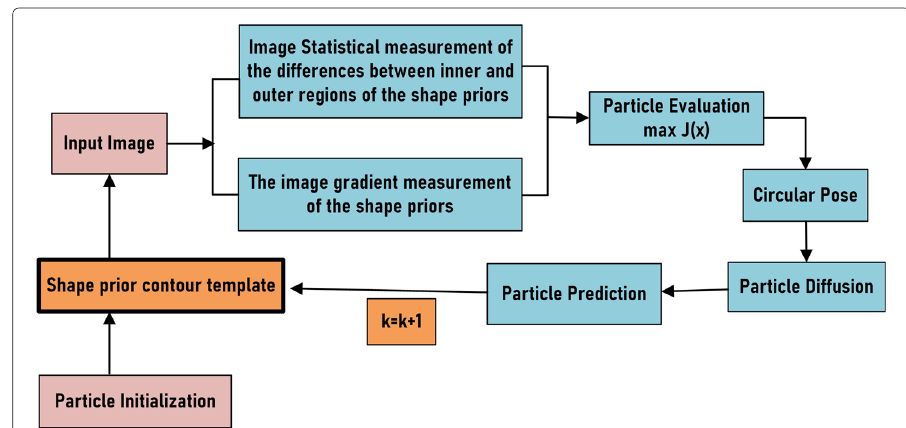
Fig. 2 The proposed algorithm for circle pose measurement